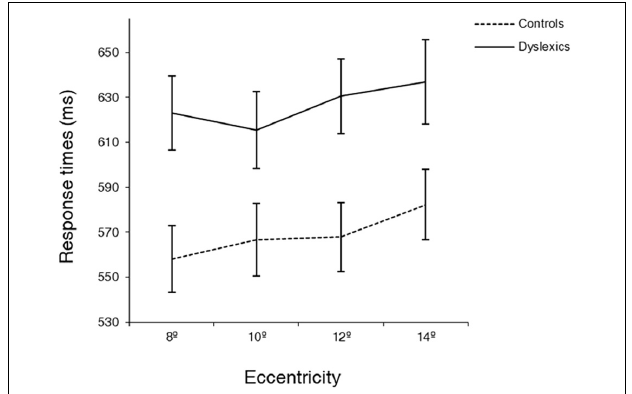
FIGURE 3 | Average response times (ms) at four eccentricities (8, 10, 12, 14 ◦ ) for dyslexics and controls. Note the different behavior of dyslexics and controls at 10 ◦ of eccentricity. Error bars indicate ±